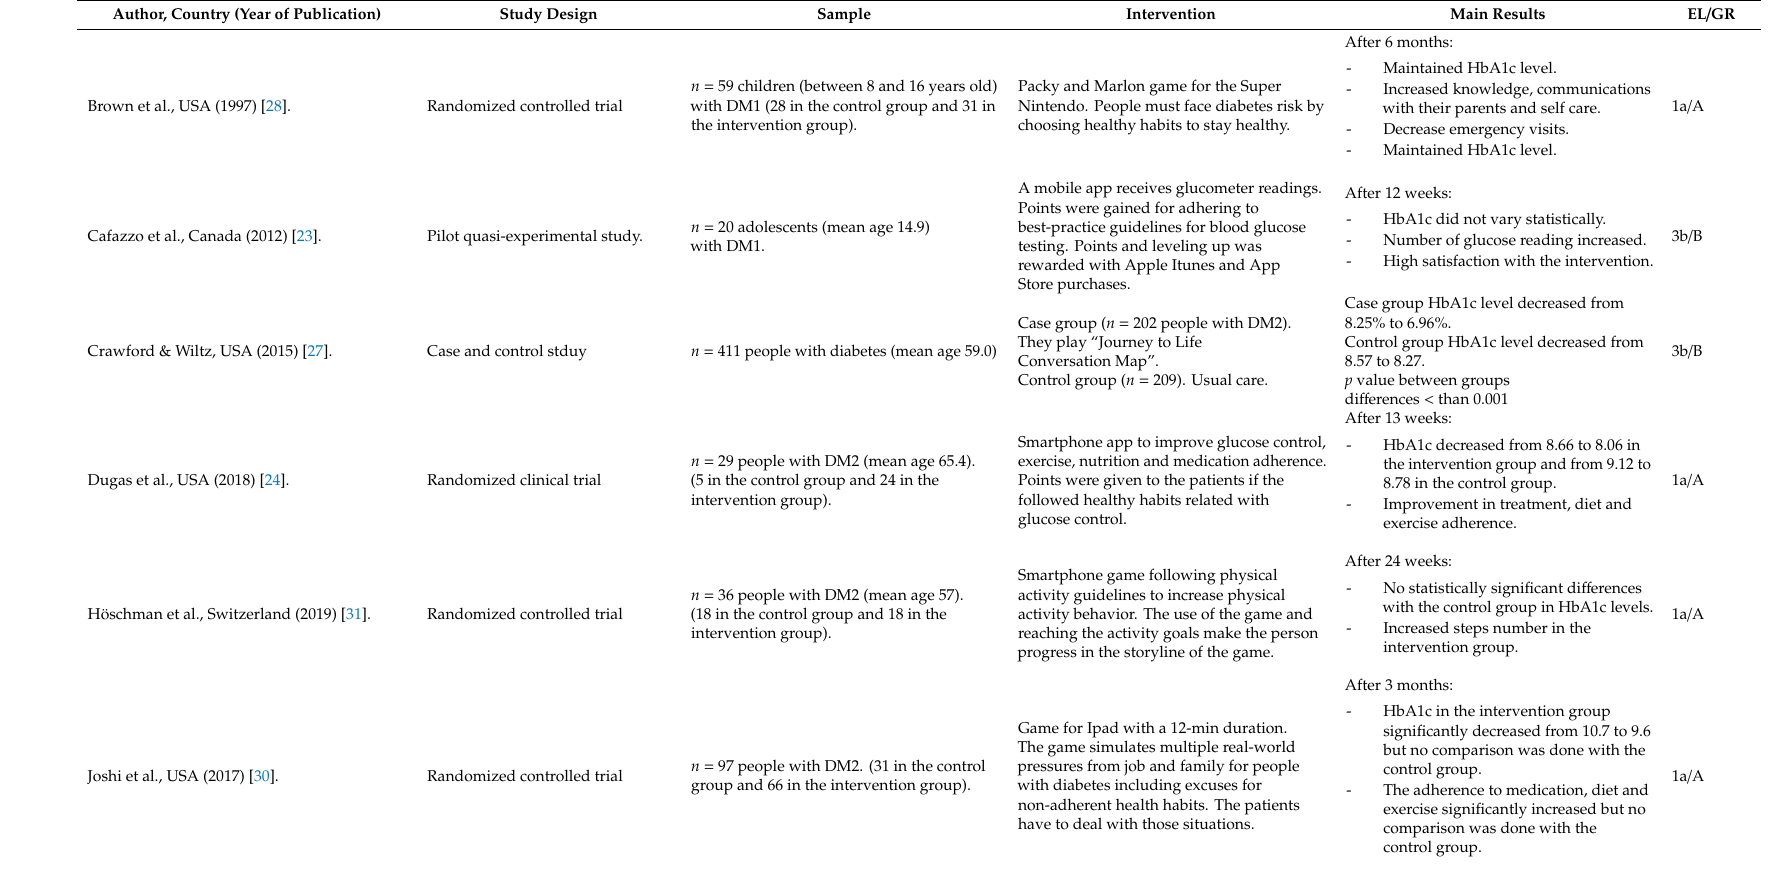
Table 2. Characteristics of the included studies ( n =